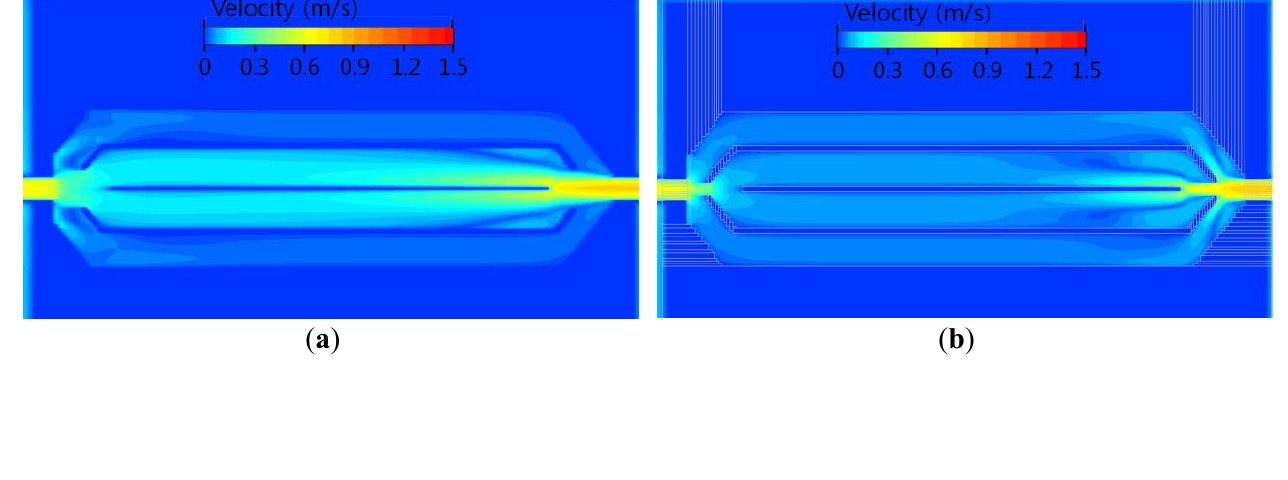
Figure 14. Velocity contours at inverter cooling channels: ( a ) 2 L/min (base guide plate); ( b ) 2 L/min (modified guide plate); ( c ) 4 L/min (base guide plate); ( d ) 4 L/min (modified guide plate); ( e ) 6 L/min (base guide plate); and ( f ) 6 L/min (modified guide